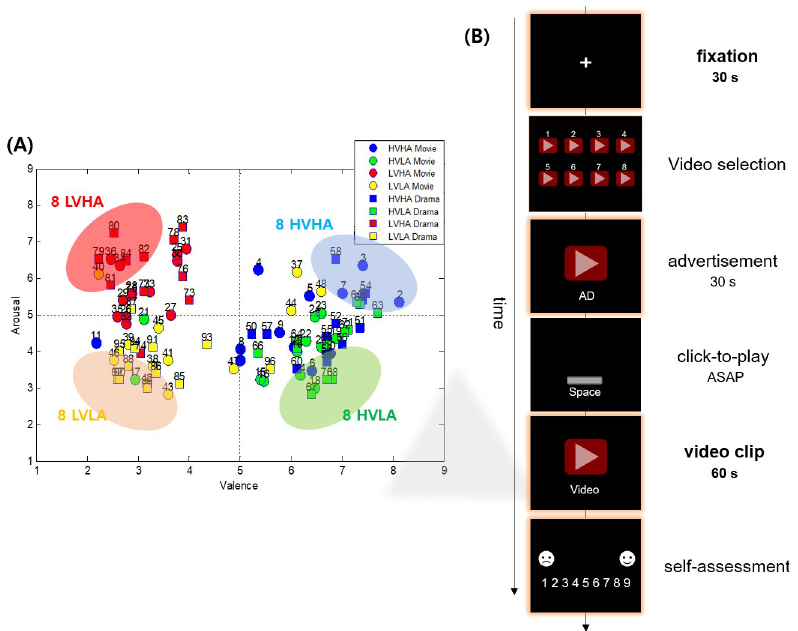
Fig 1. Experimental paradigm. (A) The distribution of the valence and arousal scores of video clips, averaged over all the participants of the pre-experiment. The finally selected video clips were indicated by shaded ellipses in the valence- arousal plane. (B) Temporal sequence of presenting visual stimuli in a single